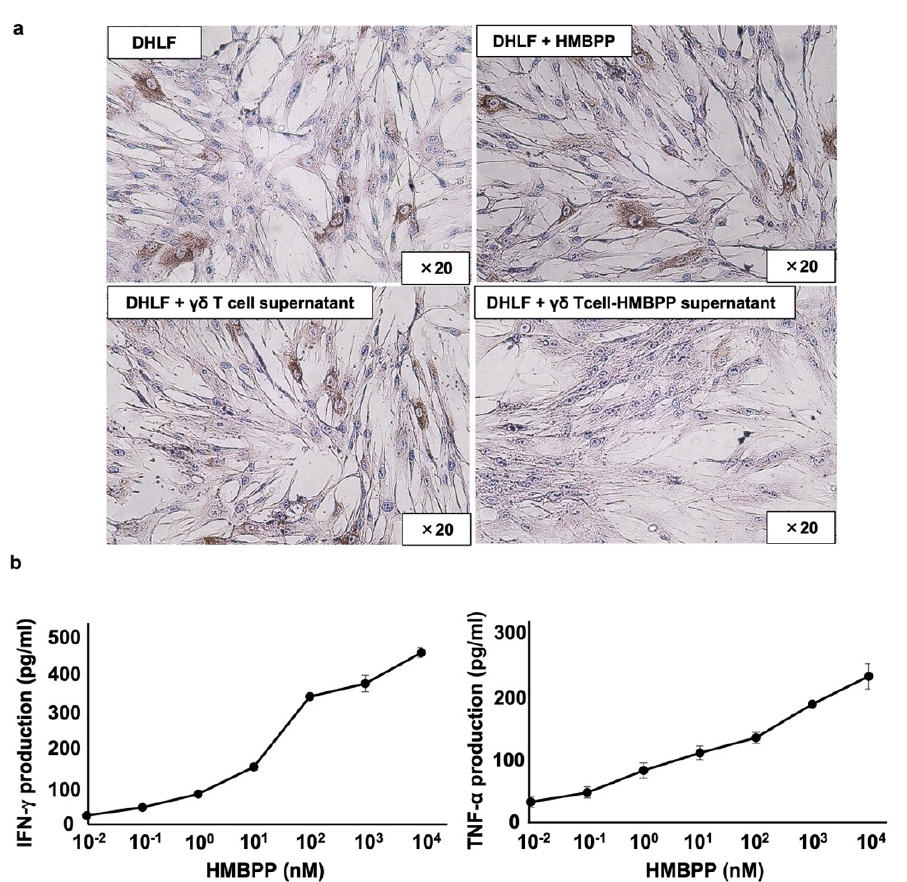
Figure 4. Effect of γδ T cell supernatant stimulated with HMBPP on collagen expression in lung fibroblasts. ( a ) Immunocytochemical analysis of collagen type I in lung fibroblasts treated with HMBPP-stimulated γδ T cell supernatant. DHLF cells (2.5 × 10 4 ) were cultured overnight in a Lab- Tek chamber slide. After the supernatants were aspirated, 1 mL of RPMI 1640 medium and 1 mL of γδ T cell supernatant (5.0 × 10 6 cells), cultured overnight in the presence or absence of HMBPP (10 μ M), were added to the chamber slide. The cells were cultured for two additional days, and collagen type I expression in DHLF cells was analyzed via immunocytochemistry. ( b ) Effect of HMBPP on IFN- γ and TNF- α secreted by γδ T cells. γδ T cells (4 × 10 5 ) were cultured with serial dilutions of HMBPP (0.01 nM, 0.1 nM, 1 nM, 10 nM, 100 nM, 1 μ M, or 10 μ M) in a 96-well flat-bottom plate. After incubation for 24 h, IFN- γ and TNF- α levels in the culture supernatants were analyzed using ELISA. Data are presented as mean ± standard deviation and are representatives of three independ- ent experiments.